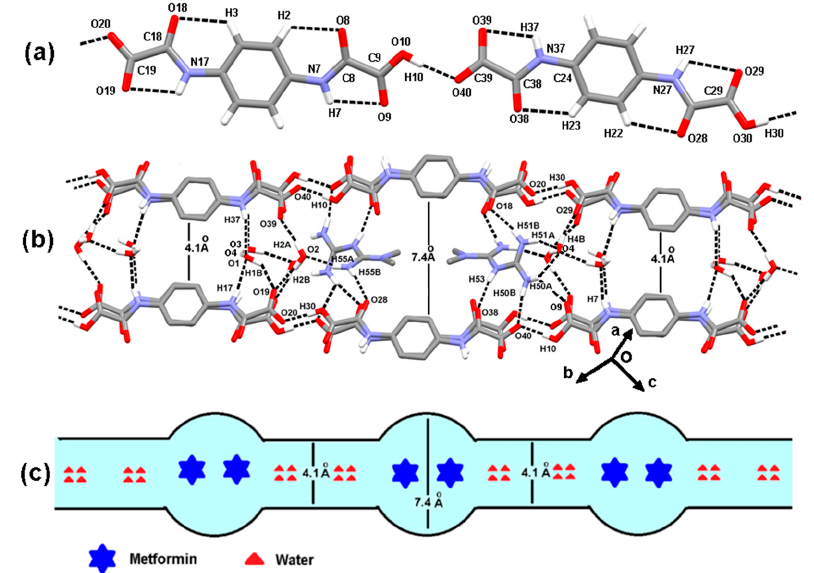
Figure 5. ( a ) Acid ··· carboxylate hydrogen bonding between the two units of HpOXA − . ( b ) Double strands of H 2 Mf(HpOXA) 2 · 4W propagating along the (1 1 − 1) plane. ( c ) Pictorial representation of H 2 Mf(HpOXA) 2 · 4W where metformin diammonium and water pockets are